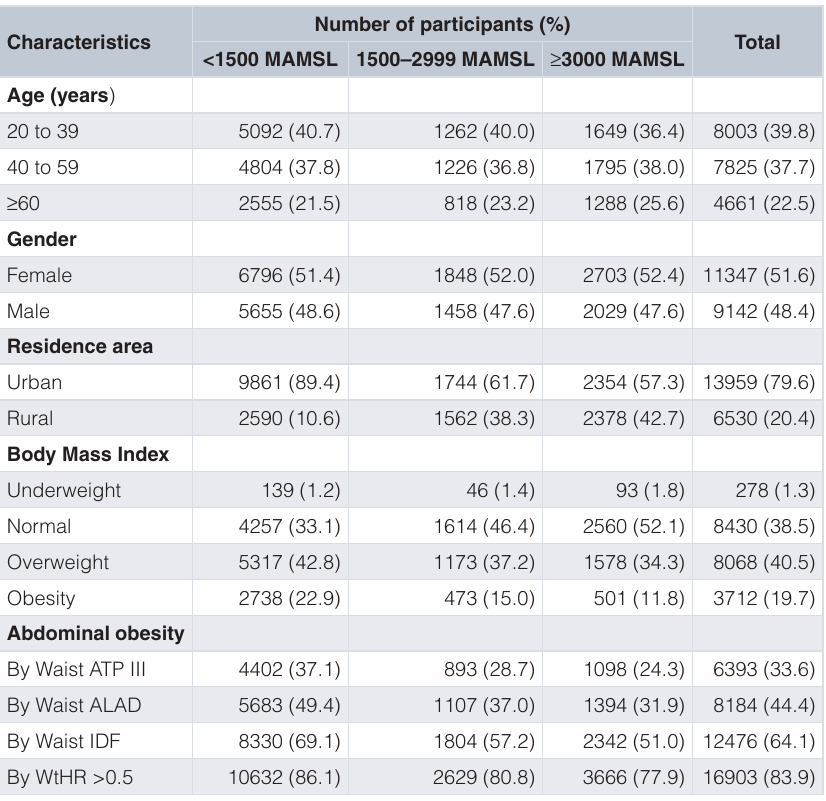
Table 1. Peru’s demographics by altitude